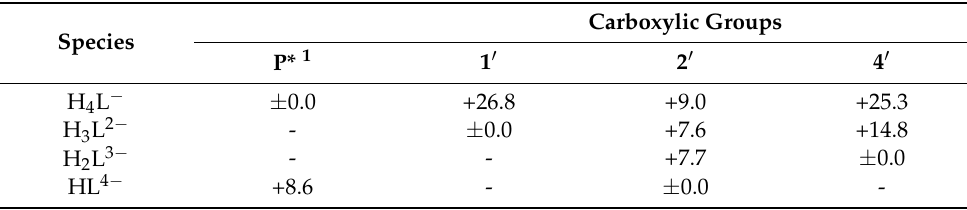
Table 2. Relative energies (in kcal mol − 1 ) calculated from DFT-optimized structures (Figure 4) for a given macrospecies deprotonated at the respective functional groups.